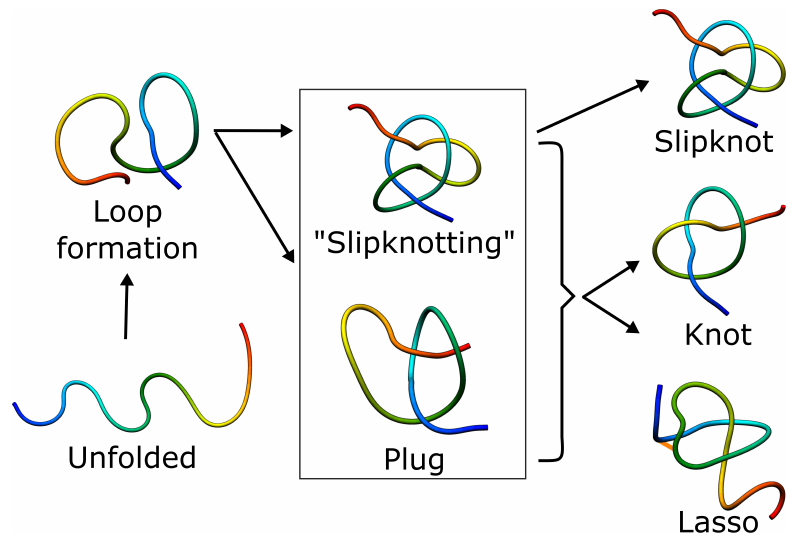
Figure 6. Schematic folding pathways of knots, slipknots and lassos. In each case, folding has to include threading of the chain, which can happen either by slipknot conformation or by direct plugging the chain. The slipknot conformation may then lead to a knot or singly-pierced